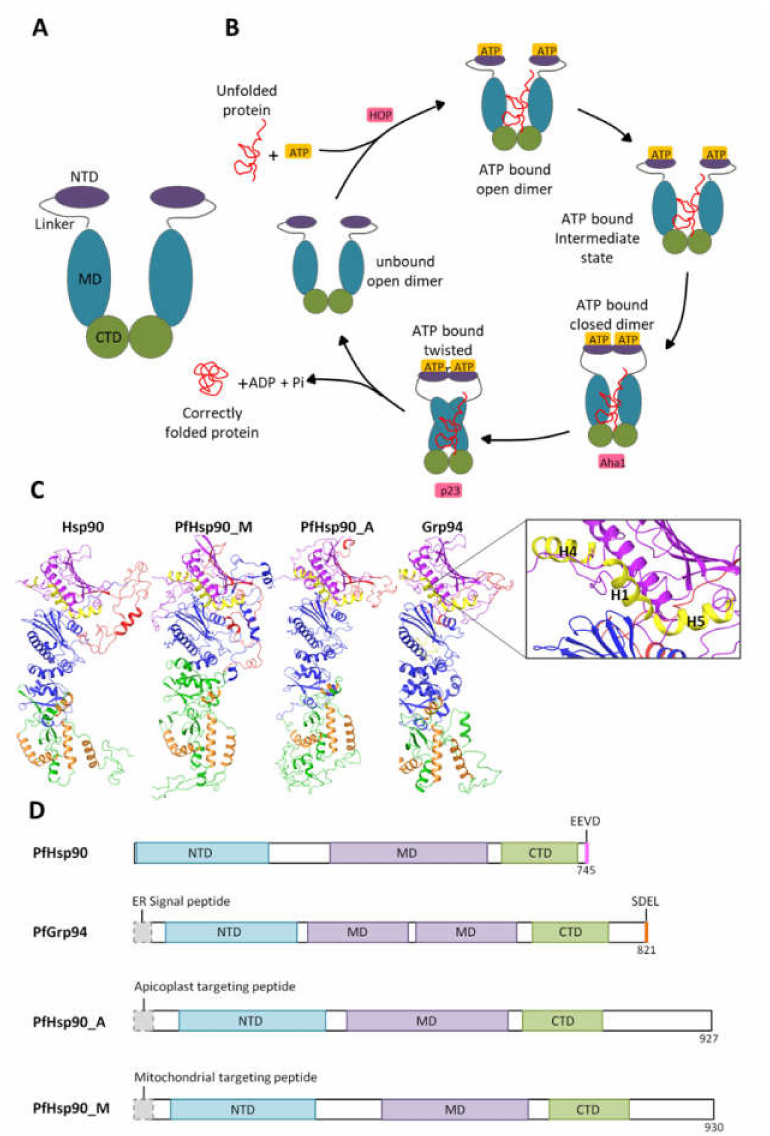
Figure 1. The nucleotide-dependent Hsp90 functional cycle and domain organization of P. falciparum Hsp90s. ( A ) Schematic of the general Hsp90 protein domain organization. ( B ) The Hsp90